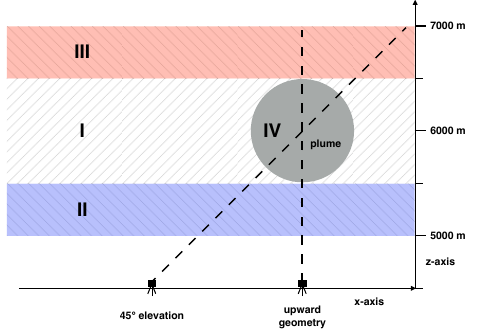
Figure 7. Sketch of the simulated geometries for the McArtim sim- ulations. A round plume with a diameter of 1km was simulated with the instrument either directly below the volcanic plume or at a hor- izontal distance. The hatched areas indicate the three different re- gions in which clouds were simulated. The fourth scenario assumes the absence of clouds but a homogeneous aerosol enhancement in- side the volcanic plume (round grey